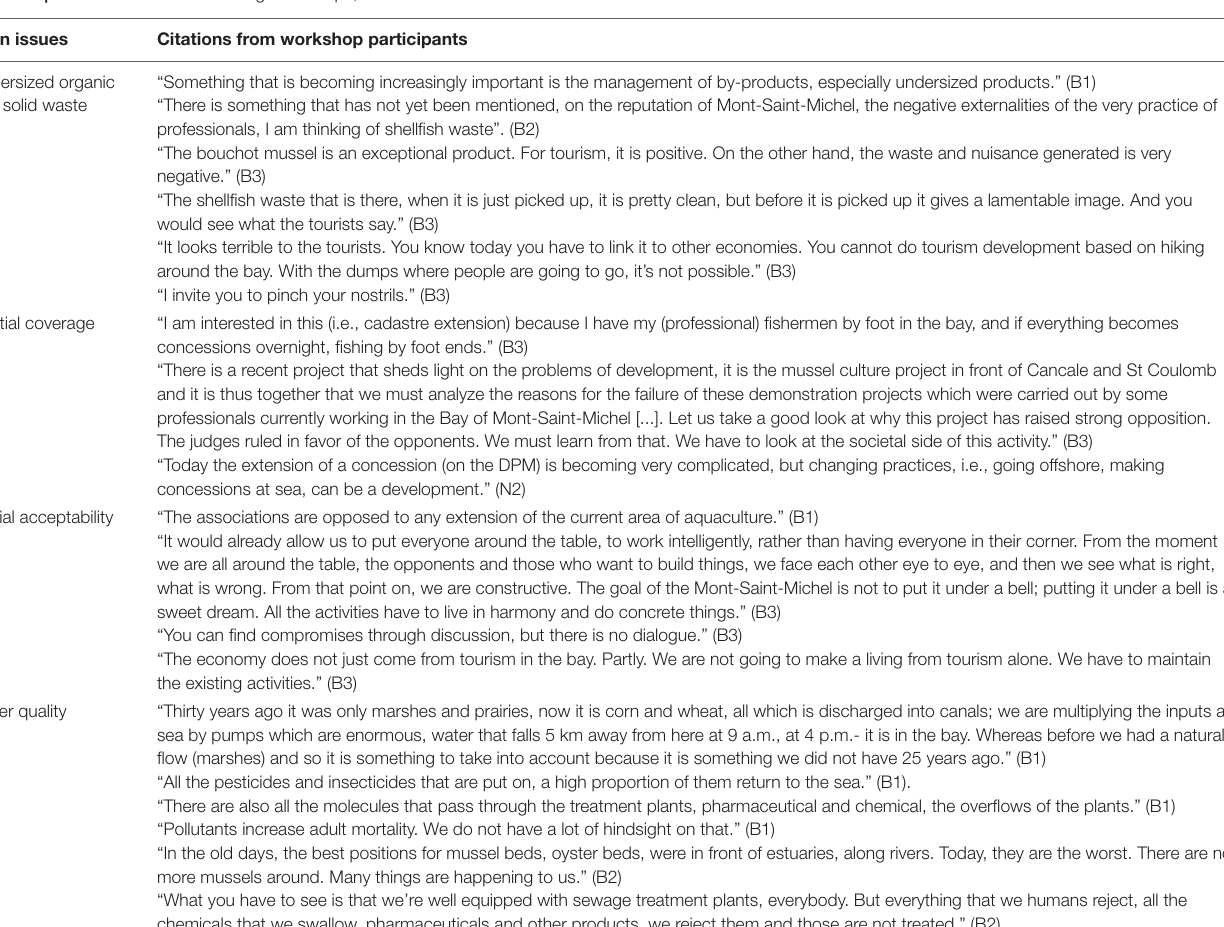
TABLE 4 | Main issues identified during workshops, with some related